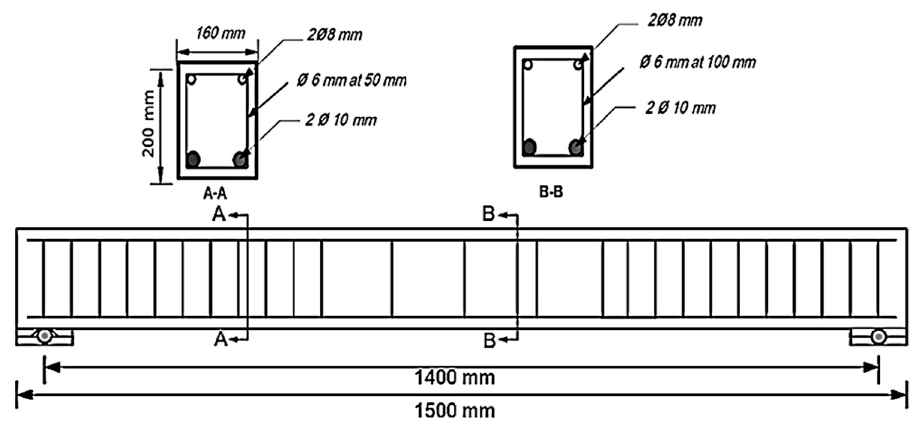
Figure 1. Concrete geometry and reinforcement details of tested specimen.